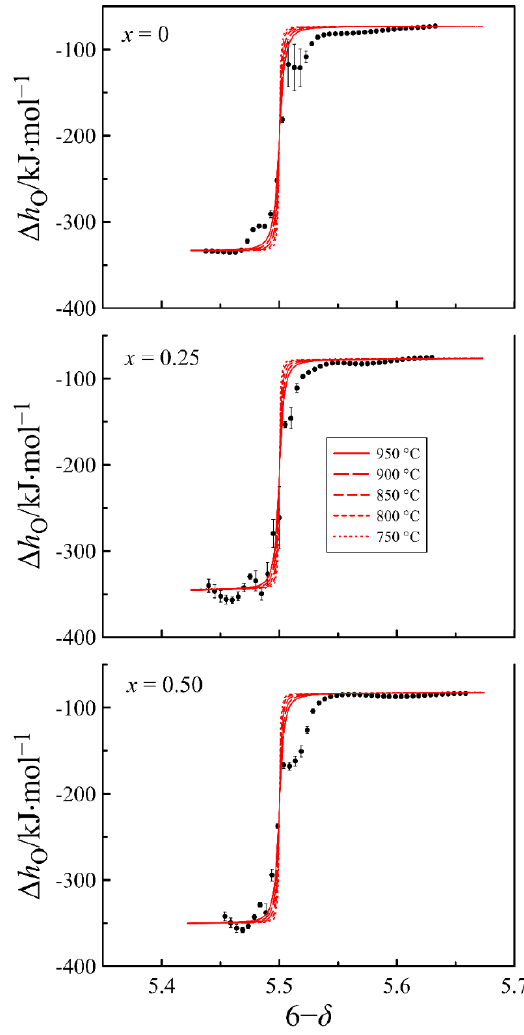
Figure 8. Partial molar enthalpy of oxygen in PrBa 1− x Sr x Fe 2 O 6− δ as a function of oxygen content in the oxides. Dots show the results obtained with the Gibbs – Helmholtz relation (16). Lines represent the results of statistical thermodynamic calculations with Equation (23).